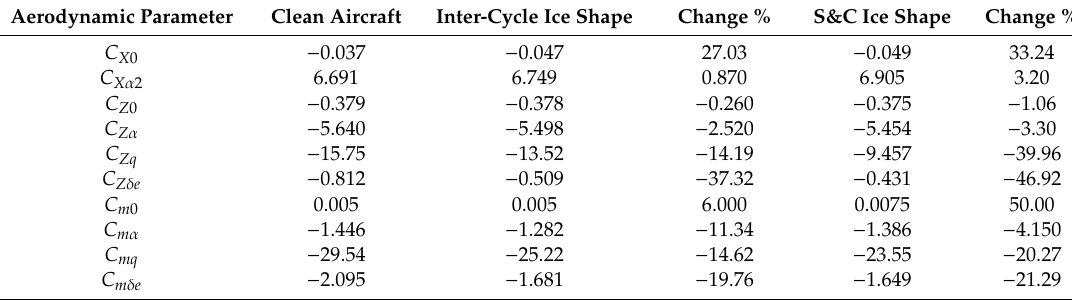
Figure 6. Angle of attack responses of horizontal tail iced aircraft. Table 6. Identification results of the horizontal tail iced aircraft